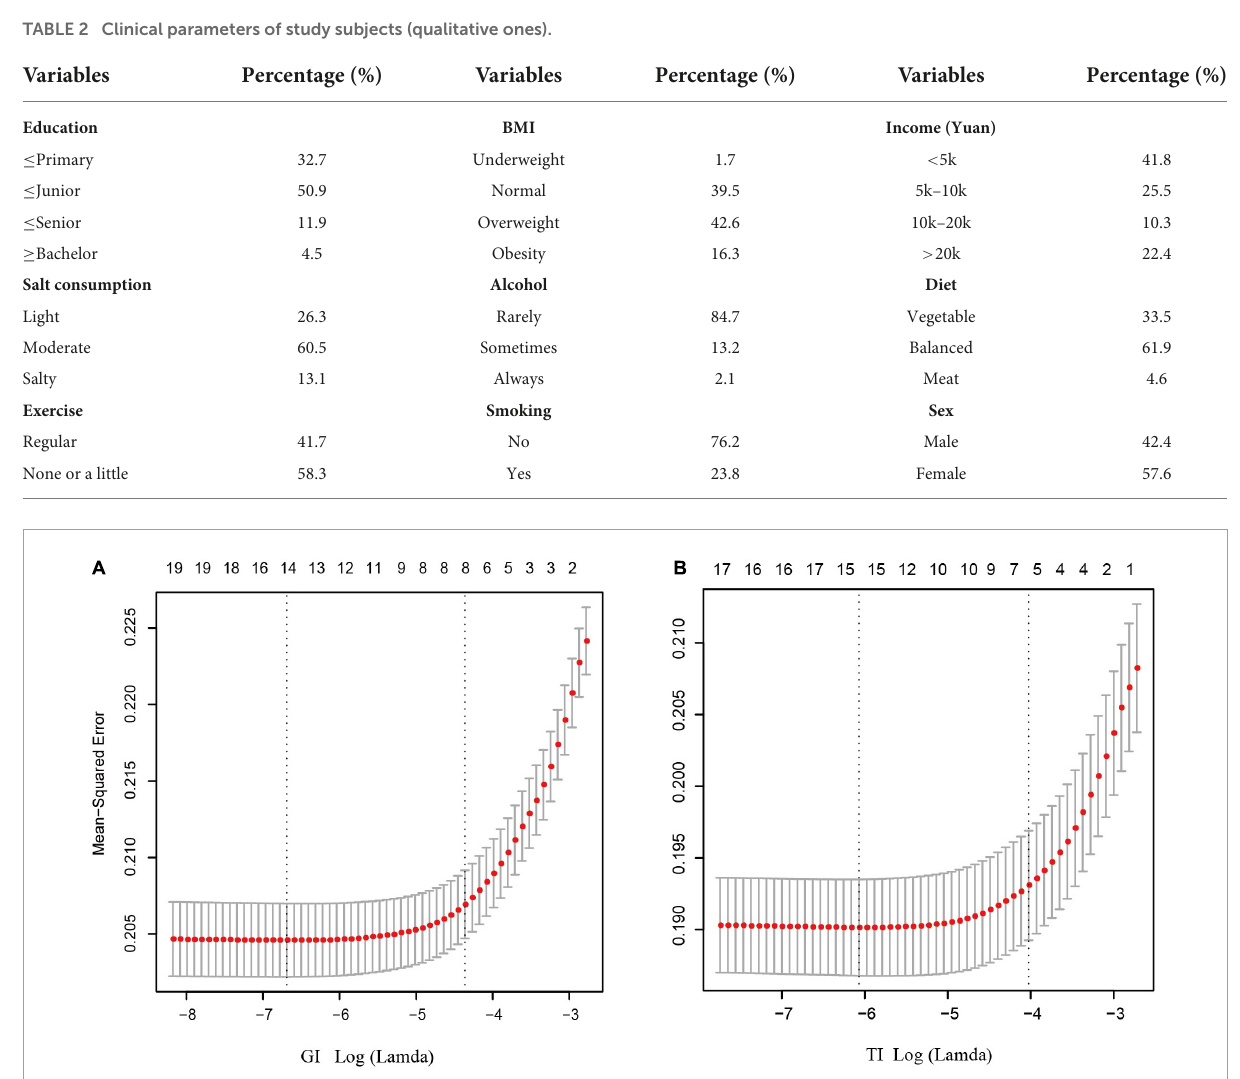
FIGURE3 Results of feature selection using LASSO. When Lamda is minimum, corresponding features were taken into model construction (14 features for GI, and 15 feature for TI). (A) Feature selection for GI; (B) feature selection for